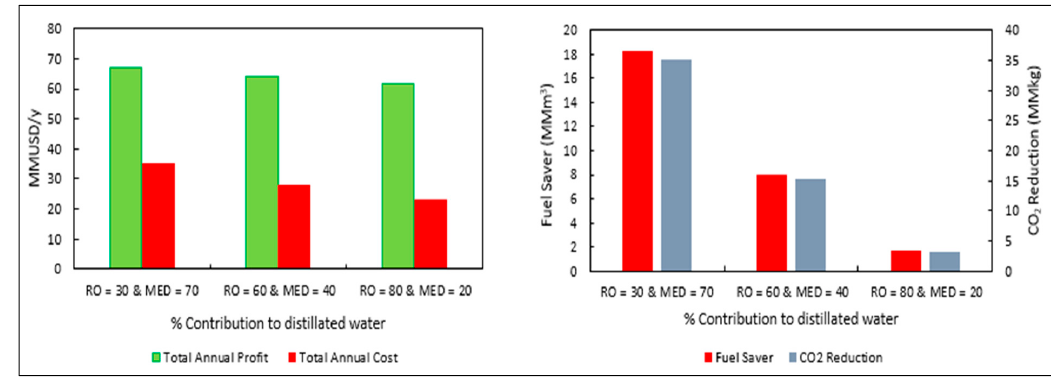
Figure 9. Comparison between the economic and environmental aspects.